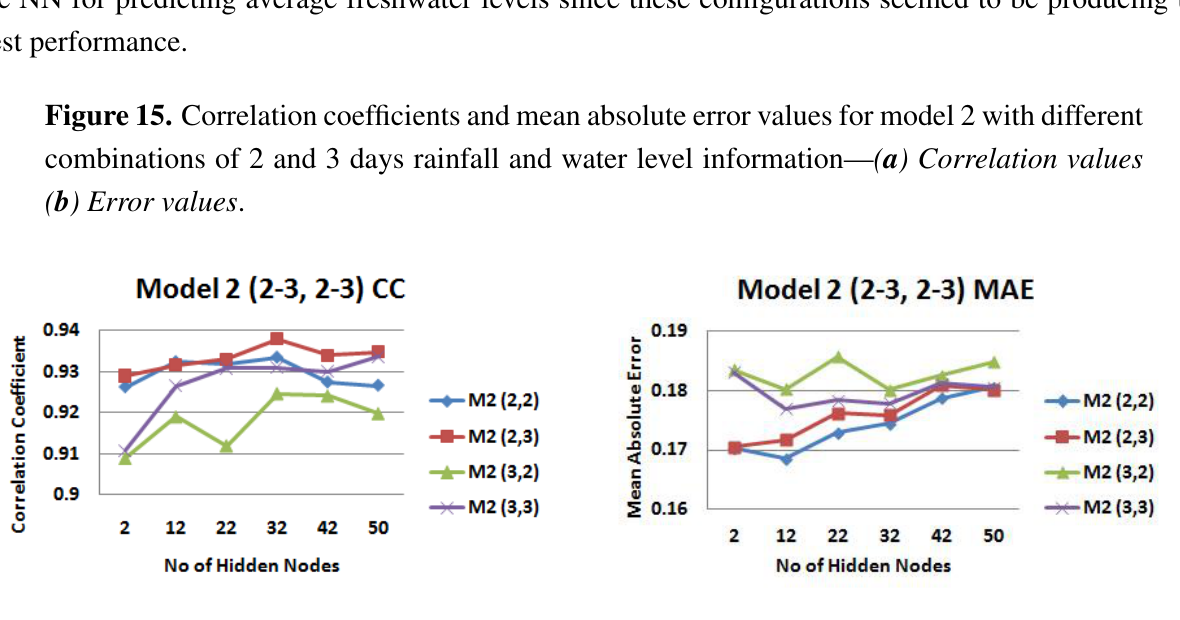
Figure 16. Correlation coefficients and mean absolute error values for model 6 with different combinations of 2 and 3 days rainfall and water level information— ( a ) Correlation values ( b ) Error values